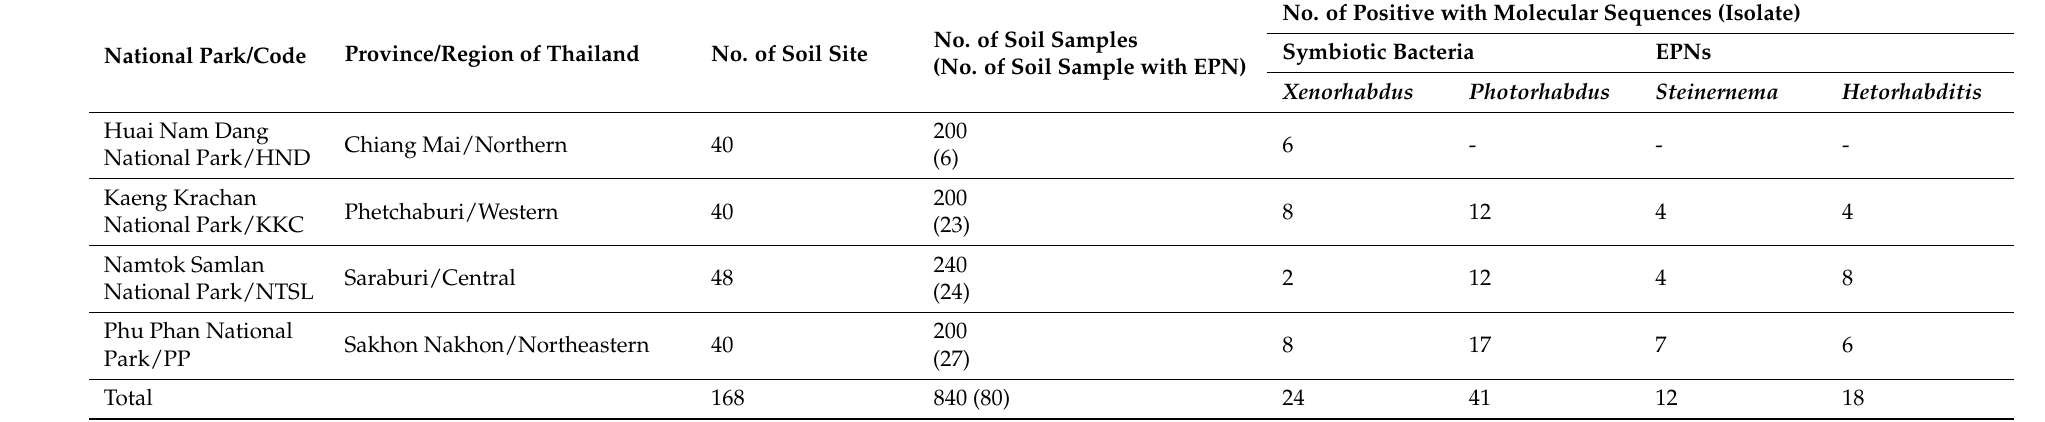
Table 1. Number and identification of EPN/bacterial species recovery form soil samples in the national parks of Thailand.